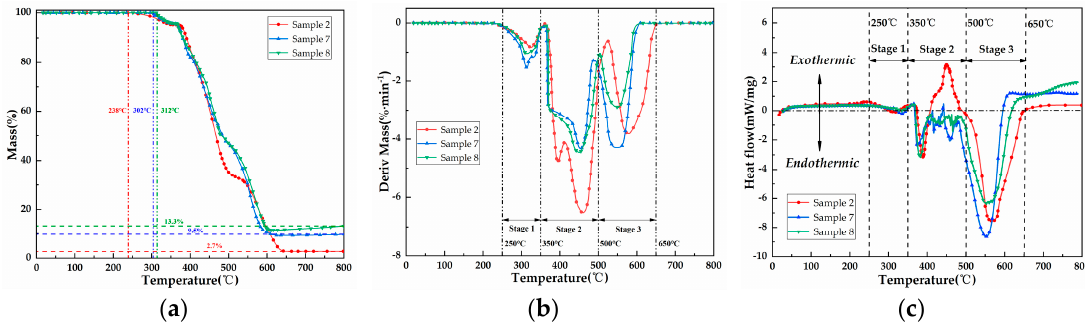
Figure 6. Results of TGA, DTG, and DSC test of asphalt binder: ( a ) TGA; ( b ) DTG; and ( c ) DSC.